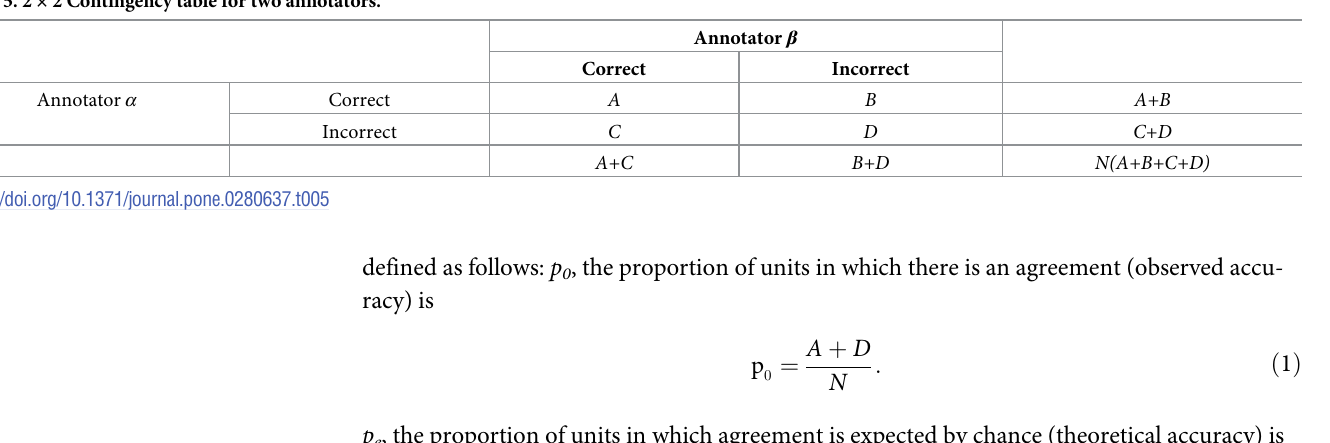
Table 5. 2 × 2 Contingency table for two annotators.